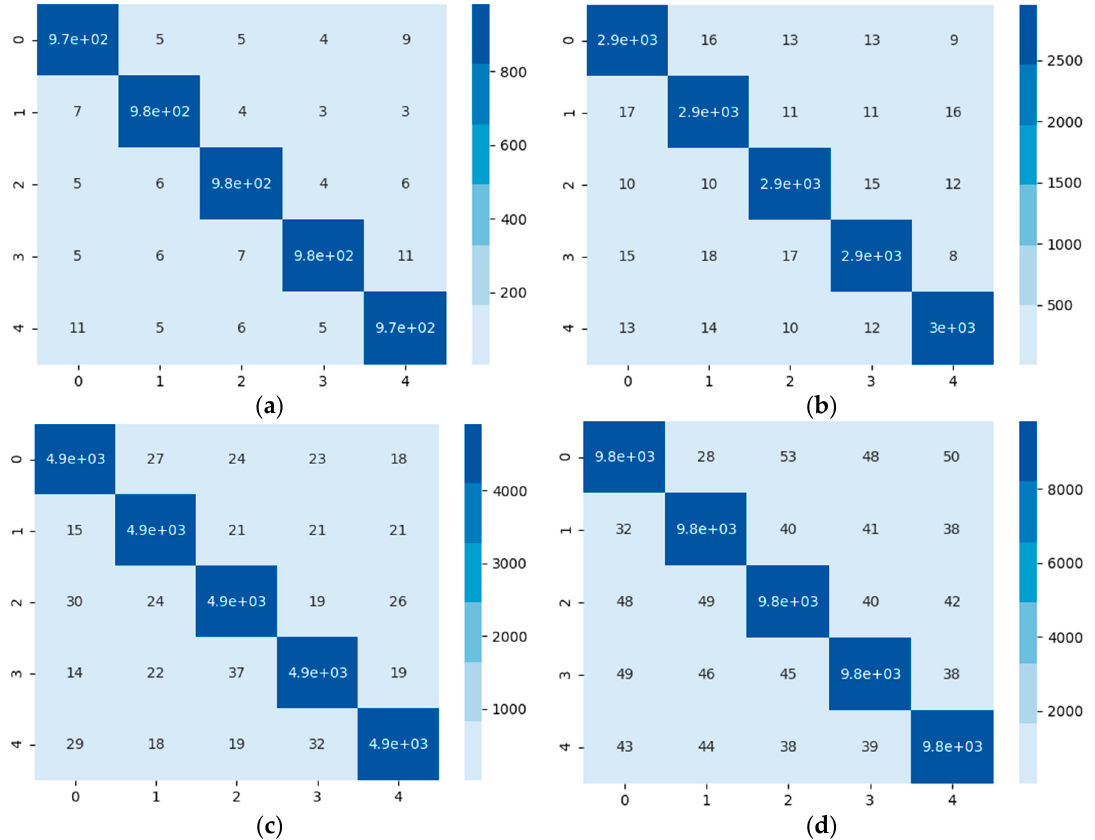
Figure 8. The confusion matrices in different tasks using the proposed method. ( a – d ), corresponding to 1-shot, 3-shot, 5-shot and 10-shot tasks.